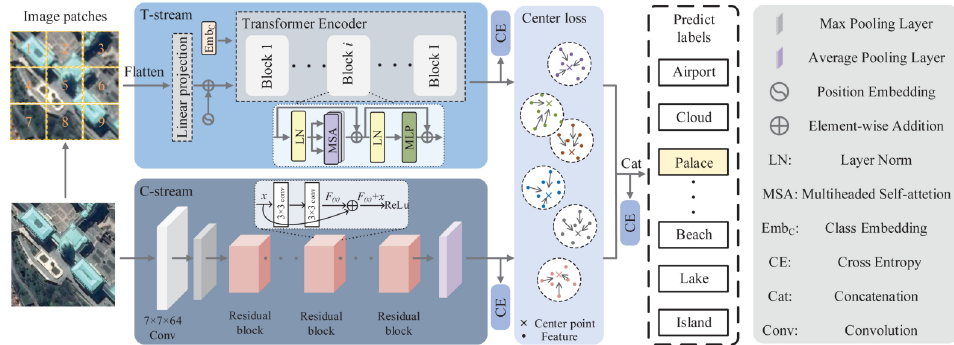
Figure 5. The CTNet architecture comprising two modules: the ViT stream (T-stream) and the CNNs stream (C-stream). The T-stream and C-stream are designed to capture semantic features and the local structural information. Figure is from [31]. Best viewed zoomed